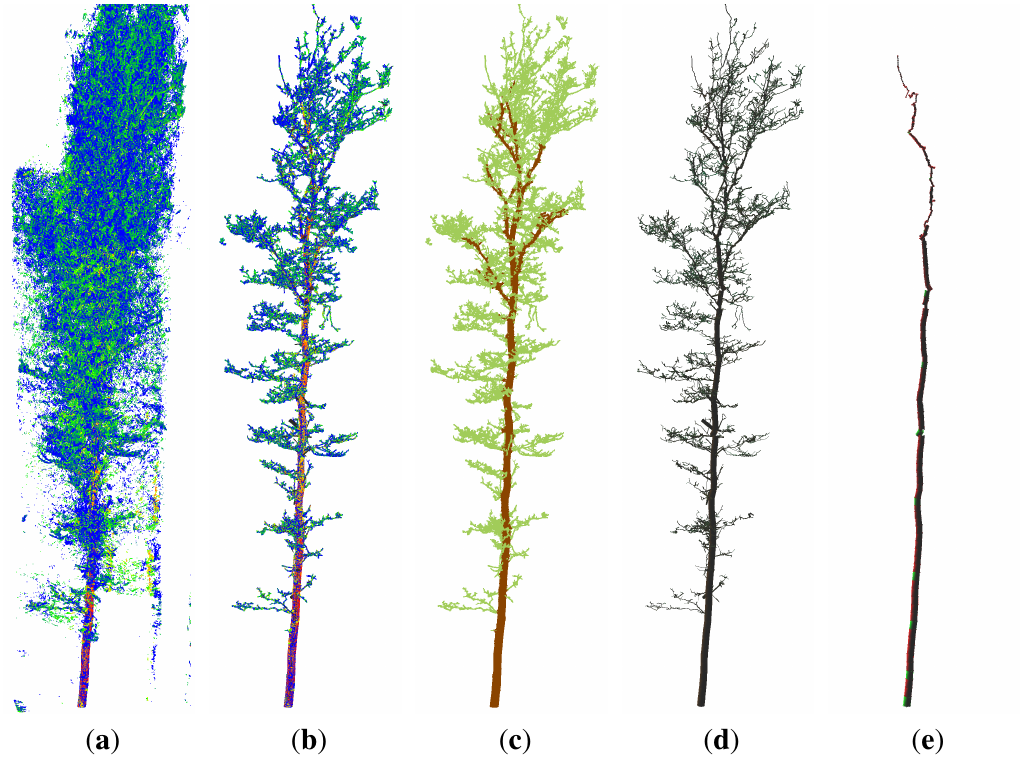
Figure 2. Processing the scan of a Q. petraea (Q#1, height ≈ 25 m): (a) input point cloud containing a large number of ghost points and compartments of other trees; (b) denoised point cloud; (c) detected stem and main branch points are colored brown; (d) the cylinder model of the tree; (e) the automatically extracted